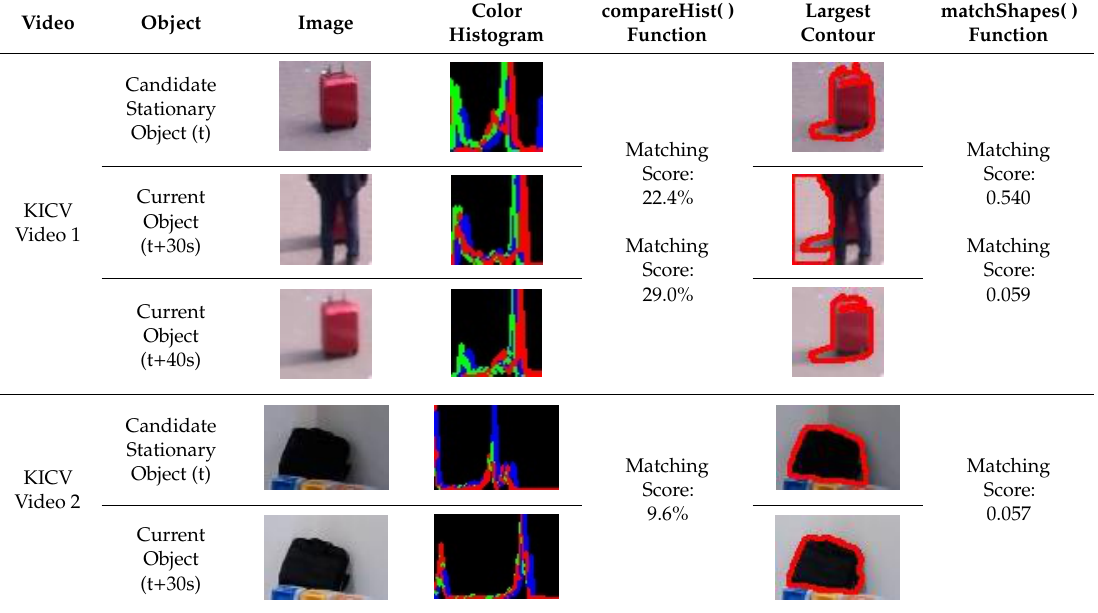
Figure 9. Indoor illumination changes in KICV video 2. Table 4. Comparison results using the color histogram and the largest contour in KCVI dataset.